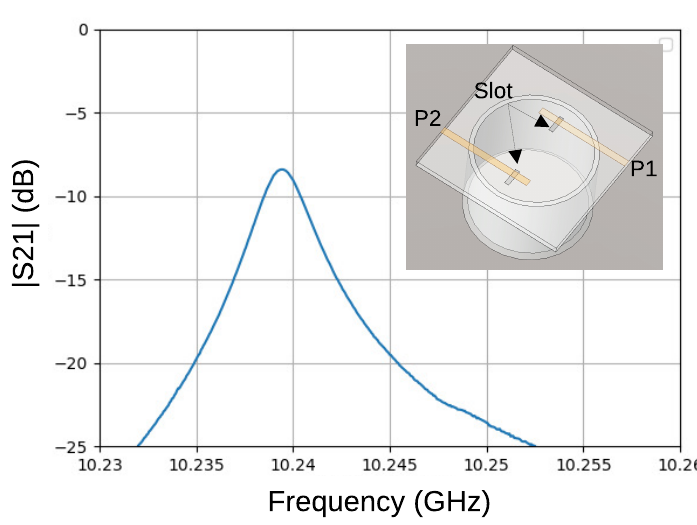
Figure 9. S21 of the oxygen-free copper based